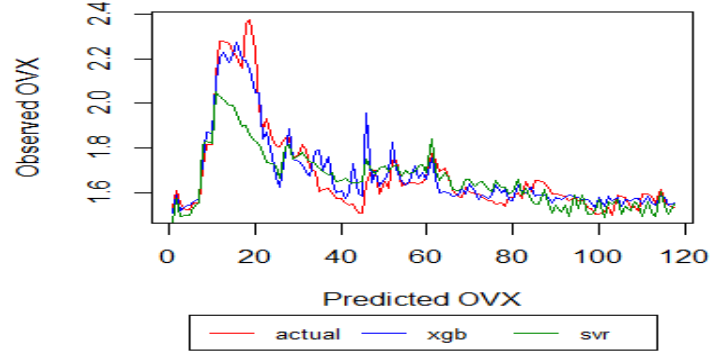
Figure 4. A plot of OVX forecasts during